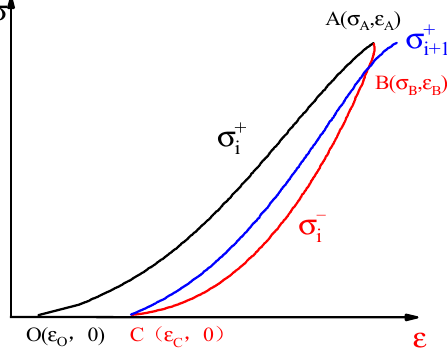
Figure 6. Diagram for calculation of energy.